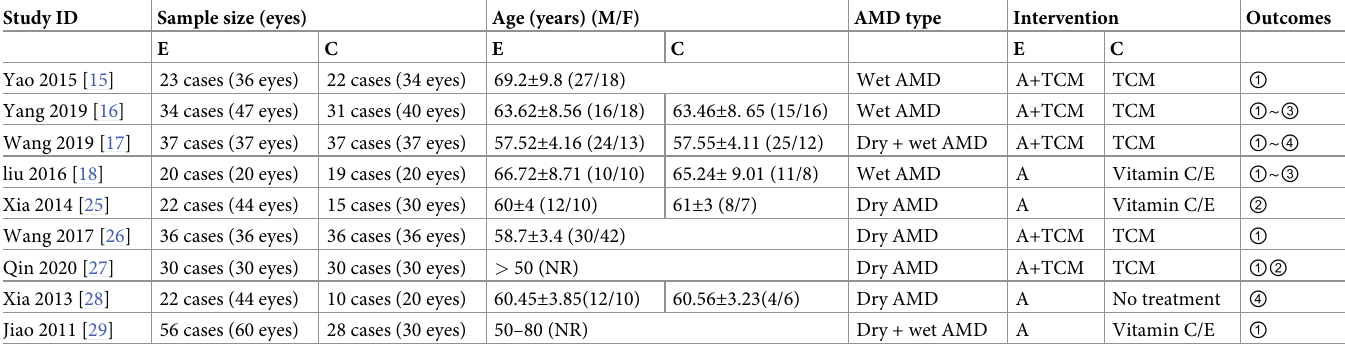
Table 1. Summary of included